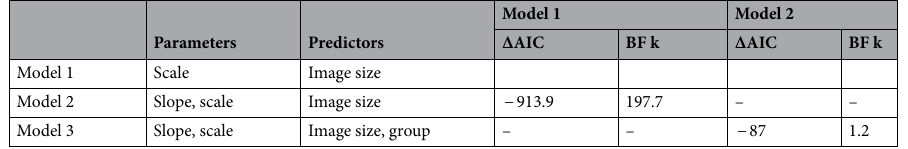
Table 1. Model comparison—retinally available SF information. Each cell describes model comparisons according to row and column. The BF k index is calculated as log10 BF, such that positive values of BF k reflect evidence in favor of the row model, and negative k values reflect evidence in favor of the column model. ΔAIC scores reflect changes in model parsimony (a function of the fit, given the number of parameters added in the row model relative to the column model). In general, negative values reflect more parsimonious fits for the row than column model and